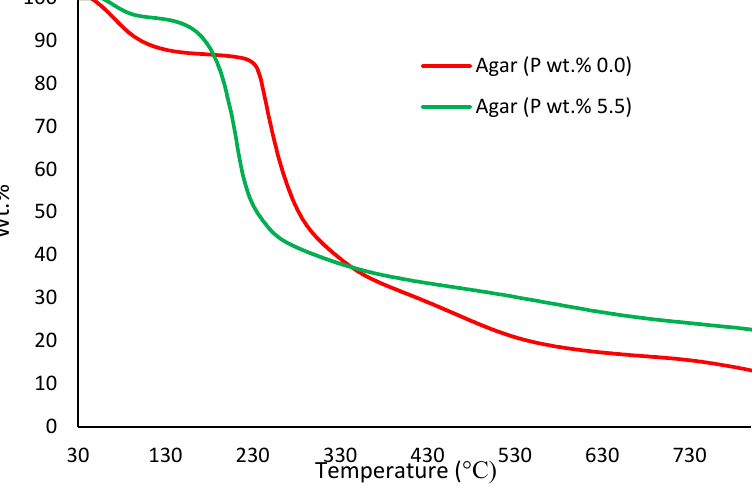
Figure 7. Thermograms of modified and unmodified versions of agar agar at 60 ◦ C / min. Table 3. Pyrolysis combustion flow calorimetry (PCFC) data for modified and unmodified versions of base substrates (average values of triplicate